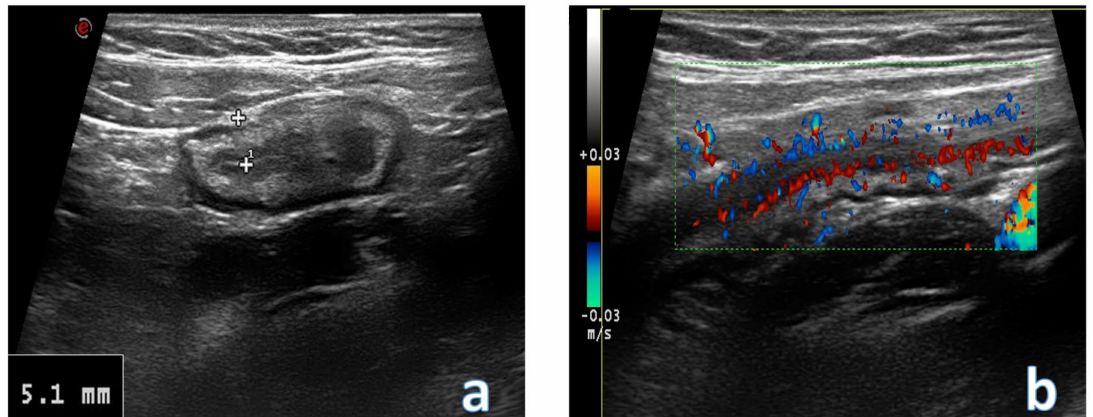
Figure 6. Images obtained with a high frequency linear probe. The image ( a ) shows a transversal scan of a section of colon with thickened walls (ulcerative colitis diagnosis); there is a hypertrophic feature of the submucosa layer. In image ( b ) the color function is inserted, which shows a hypervas- cularization of the wall, compatible with acute ulcerative colitis